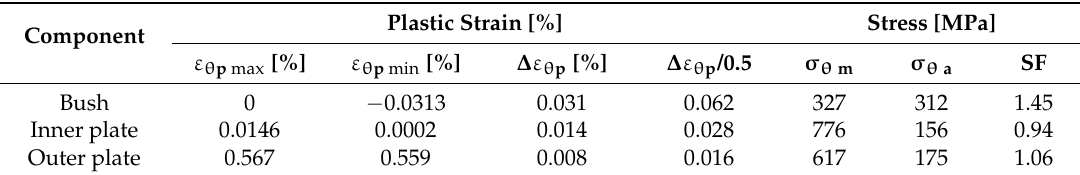
Figure 16. Plastic region of outer plate ( σ yield = 970 MPa : plastic region): ( a ) press-fitting state; ( b ) tensile state; ( c ) sprocket-engaging state.